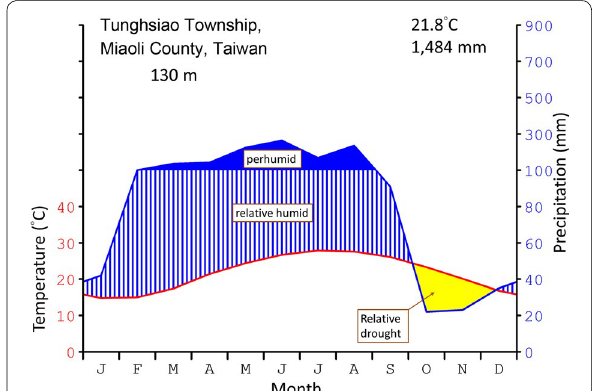
Fig. 2 Flower morphology, scale culture, and plant regeneration of Lilium callosum found in Taiwan. a Flower of Lilium callosum in native habitat in Tunghsiao Township, Miaoli County, Taiwan. (Bar c Small bulblets regenerated from scales after 8 weeks of culture. (Bar bulbs were taken out of the test tube, analyzed, and transplanted into a pot. (Bar numerous leaves.